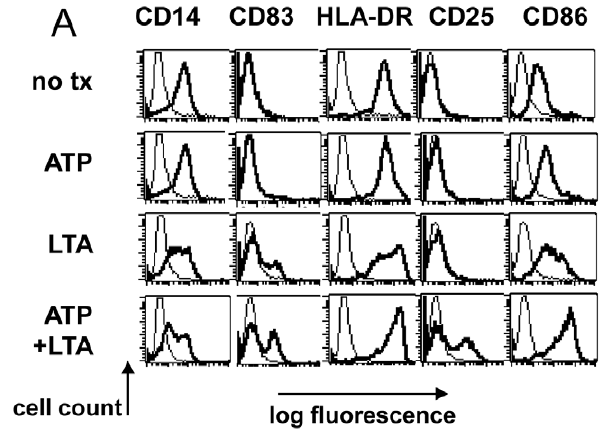
Figure 2. LTA and ATP act synergistically to induce elements of mature DC phenotype from human monocytes. A. FACS analysis of monocytes 24 hours after LTA-induced maturation. Harvested cells were stained with PE- or FITC-conjugated antibodies of the indicated specificities (heavy traces) or isotype-controls (light traces). Results shown from one of four representative